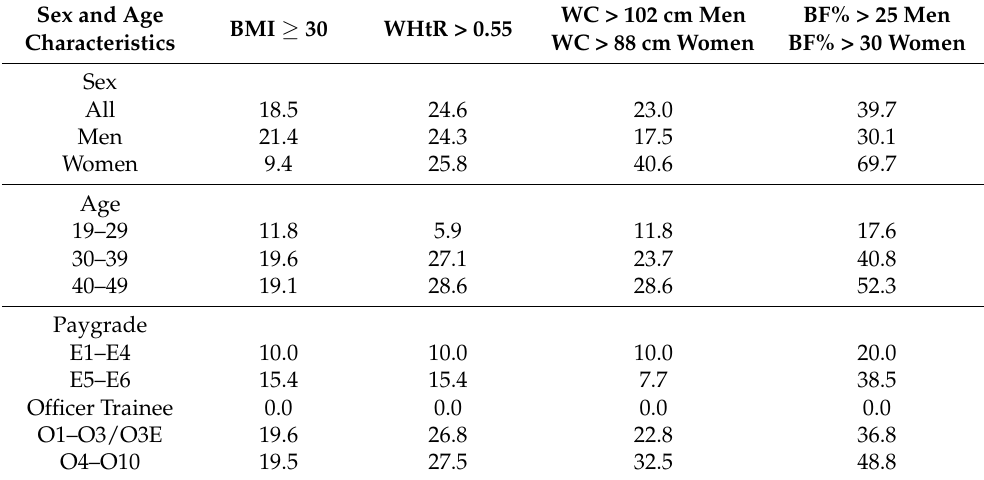
Figure 1. Loess curves for the relationships among measures of body composition by sex. Table 2. Obesity prevalence evaluated using different measures relative to sex, age, and military rank. Sex and